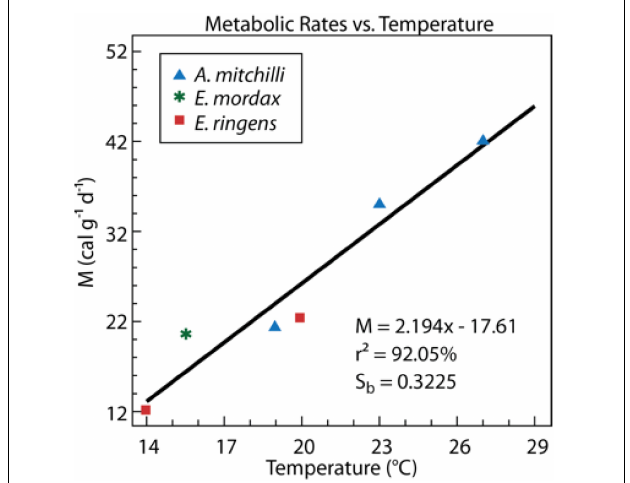
FIGURE 6 | Weight-specific metabolic rates ( M , calories g-1 day-1) at different temperatures ( T , ◦ C) for three anchovy species, A. mitchilli the bay anchovy, a coastal species; Engraulis mordax the northern anchovy from the California current; Engraulis ringens , the Peru anchoveta , from the Humboldt Current. Figure adapted from Vazquez and Houde